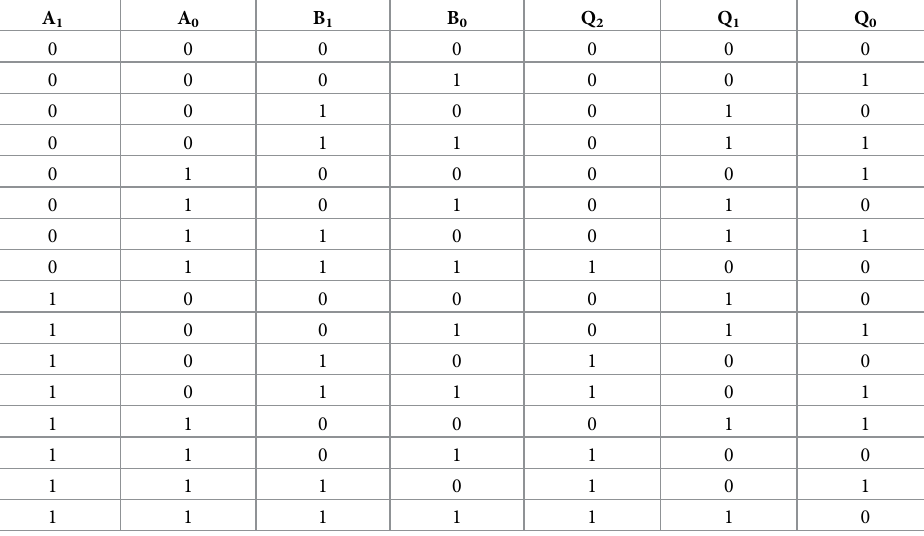
Table 3. Truth table for a two-bit addition